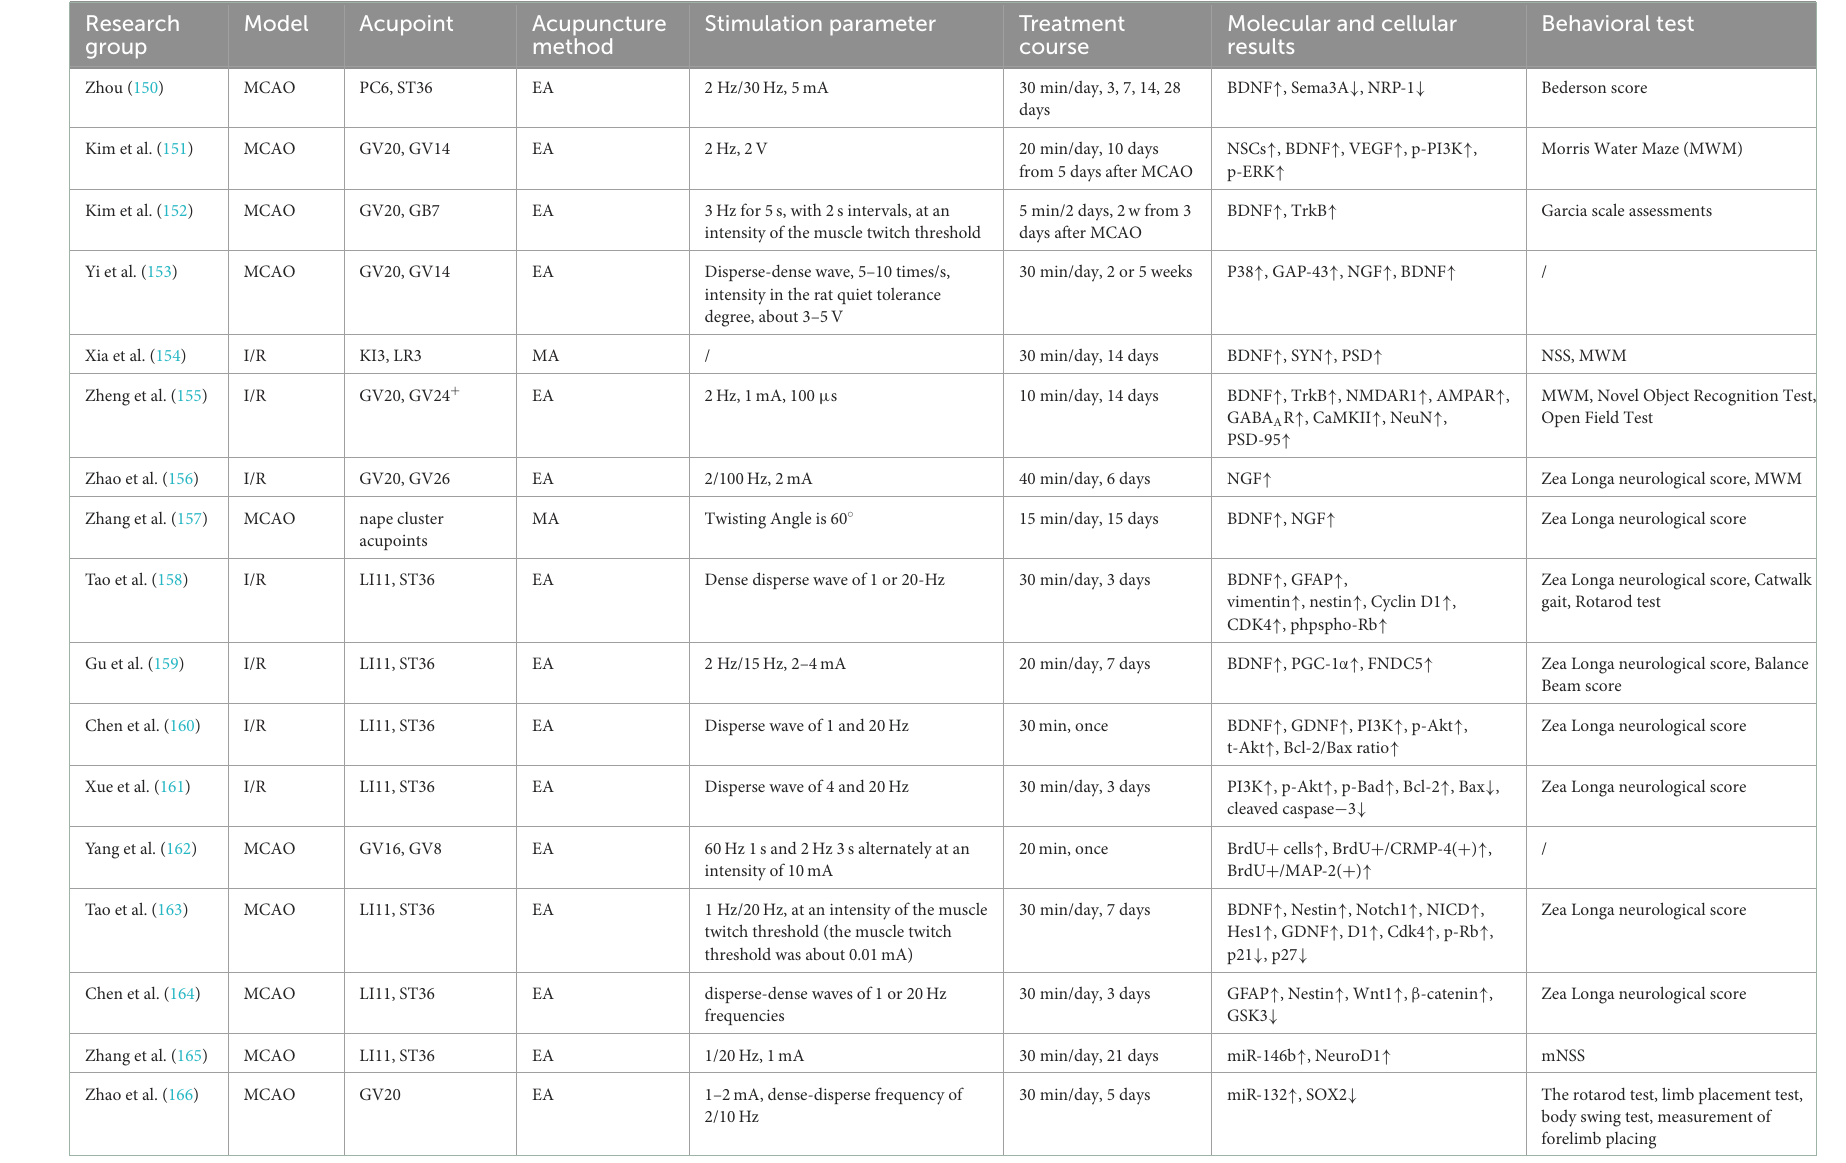
TABLE 1 Summary of the studies investigating acupuncture’s effects on functional recovery improvement after stroke via regulating neurogenesis factors.